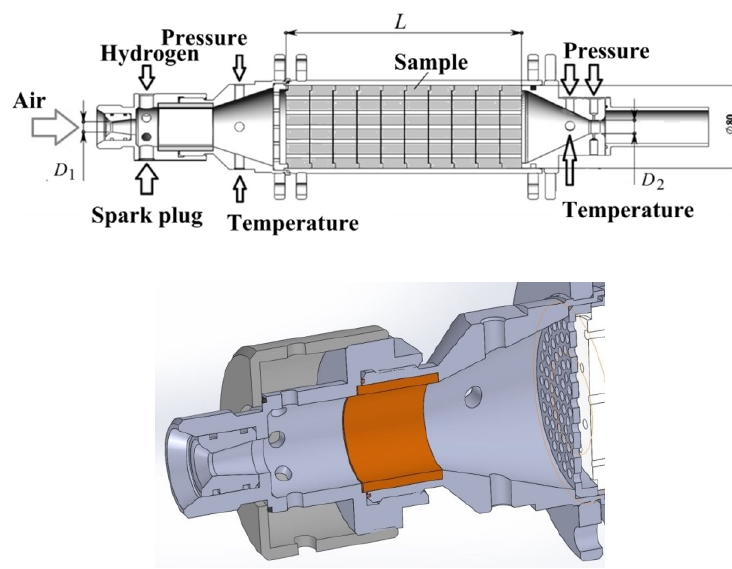
Figure 3. Gas generator with hydrogen-assisted ignition.